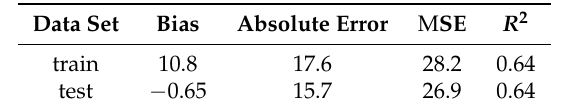
Table 3. Multi-Layer Perceptron (MLP) ice concentration estimation results compared to the MODIS estimates. The values are given in percentage points. MSE: mean squared error.